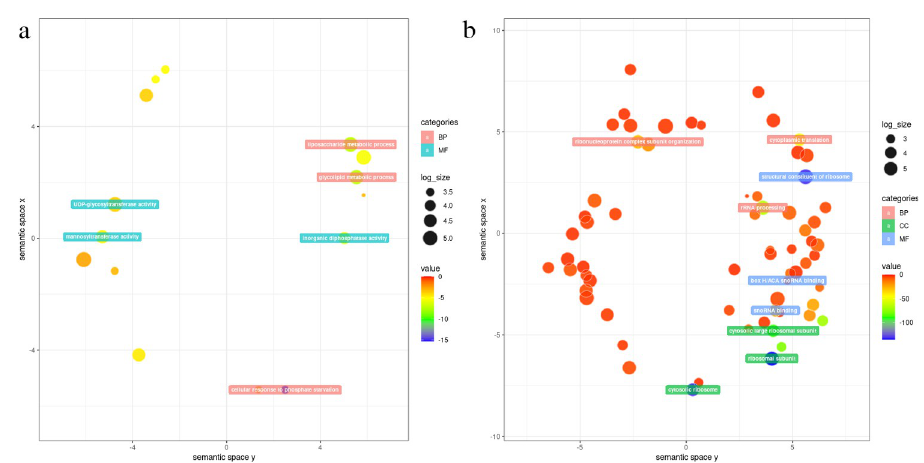
Fig 9. GO analysis results of each module. (a)Genes in blue 4 module. (b)Genes in lightlateblue module.